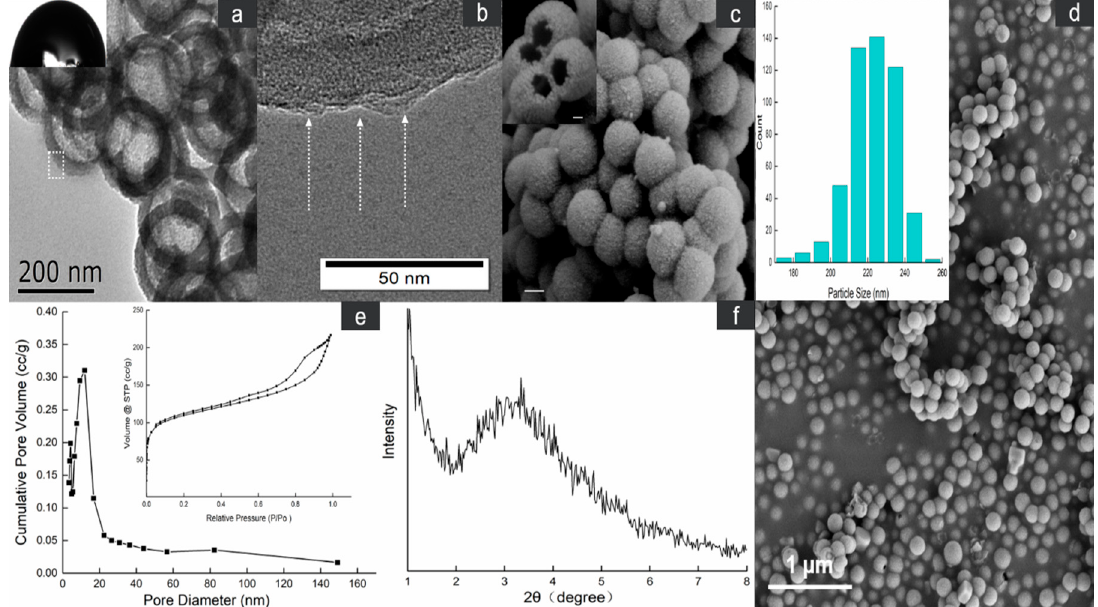
Figure 4. ( a , b ) TEM,( c , d ) SEM, ( e ) pore size distribution curve under desorption pattern, and ( f ) SMXRD images of organic hollow mesoporous silica with the highest oil-loading r. Insert in ( a ) shows WCA image. The scale in ( c ) was 100nm. Insert in ( c ) shows a partially crushed sphere, in which the scale was 50nm. Insert in ( d ) shows the average particle size. Insert in ( e ) shows the isotherm